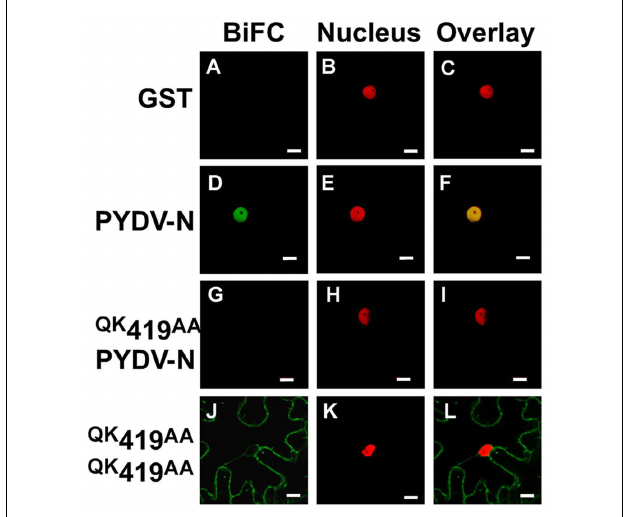
FIGURE 7 | Confocal micrographs showing results of BiFC assays to determine the ability to self-associate. Interaction assays were conducted in leaf epidermal cells of transgenic N. benthamiana expressing a fluorescent nuclear marker (Nucleus). (A–C) GST, as a non-binding control. (D–F) Self-interaction of wild-type PYDV-N. (G–I) BiFC between PYDV-N and an N mutant that is incapable of nuclear import. (J–L) Self-interaction of QK419AA mutant of PYDV-N. All N-NLS mutants were found to retain the ability to self-interact (data not shown). Scale bar = 10 μ m.